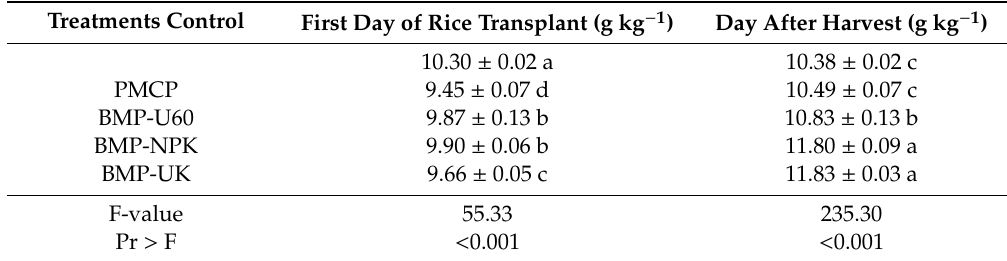
Table 4. Carbon contents in the soils treated with di ff erent supplemented biochar manure pellet fertilizers on first day of rice transplant and day after harvest *.